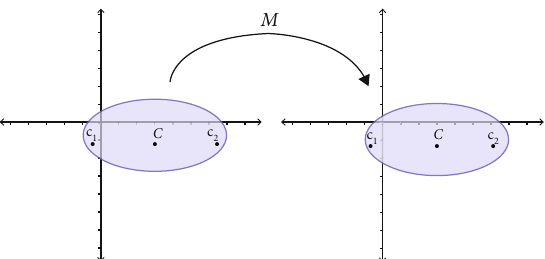
Figure 2: The blue line and its interior demonstrate the ellipse ð E ð c , c , 8 ÞÞ and elliptic disc ð E D ð c 1 2 fi xed by map M